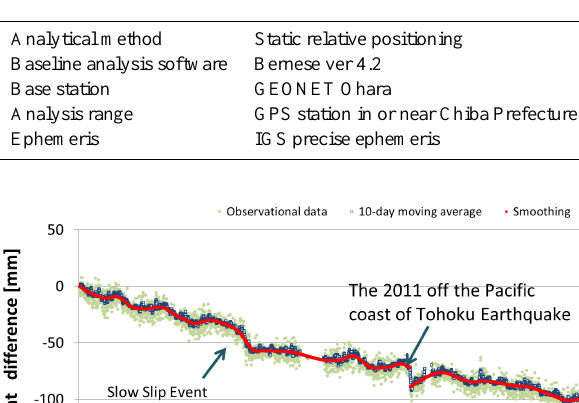
Figure 1. GPS station in Chiba Prefecture.